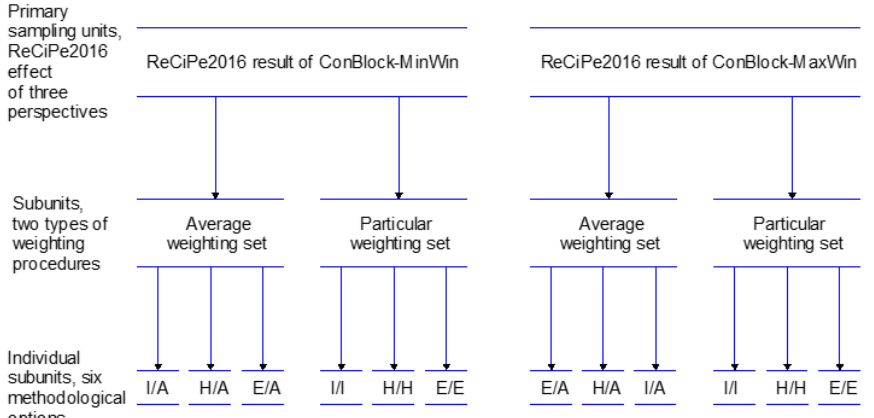
Figure 3. Two-stage ANOVA hierarchical design structure applied to environmental evaluation of CB MinWin , CB MaxWin , AAB MinWin , and AAB MaxWin (ReCiPe2016 methodological options: egalitarian/egalitarian (E/E), egalitarian/average (E/A), hierarchist/hierarchist (H/H), hierarchist/average (H/A), individualist/individualist (I/I), and individualist/average (I/A)).